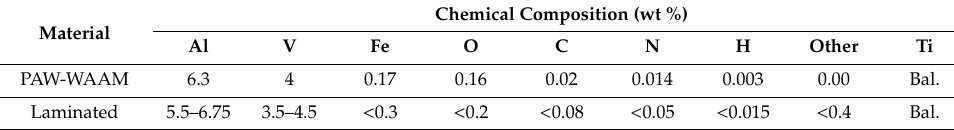
Table 6. Chemical composition of WAAM and